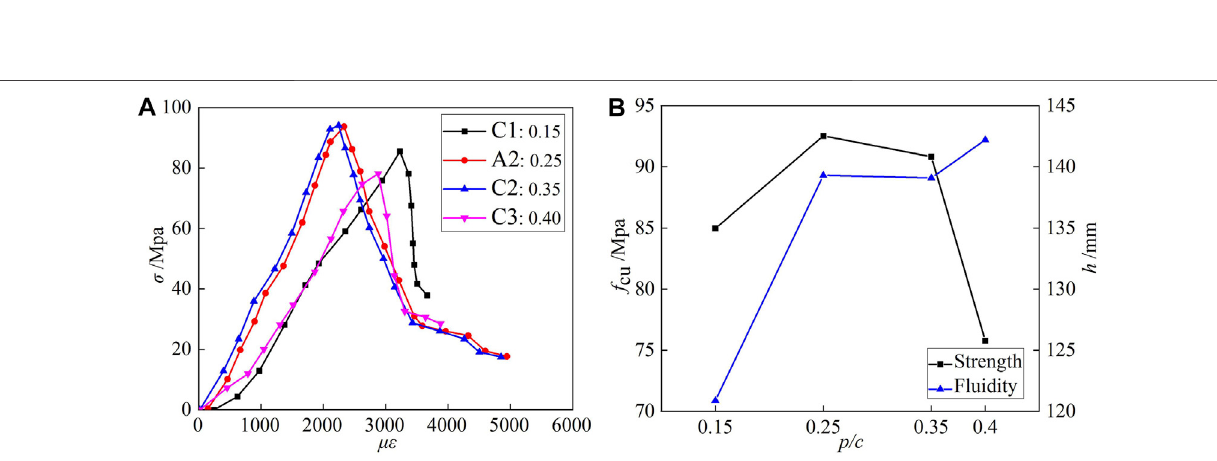
Frontiers in Materials |